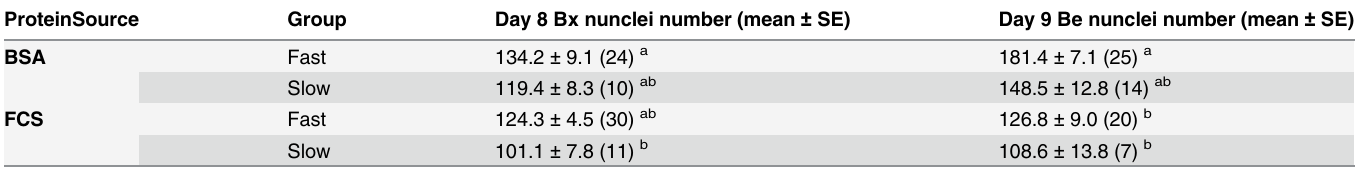
Table 2. Nuclei number of expanded blastocysts 8 days after IVF (Bx — D8) and from hatched blastocysts 9 days after IVF (Be — D9) classi fi ed according to the speed of development (Fast or Slow) and sources of protein (BSA or FCS).